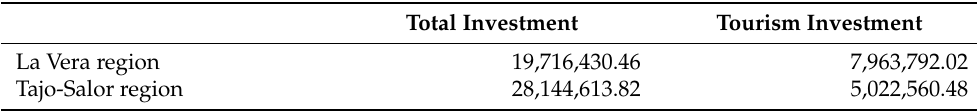
Table 6. Comparison between total and tourism investment. Total Investment Tourism